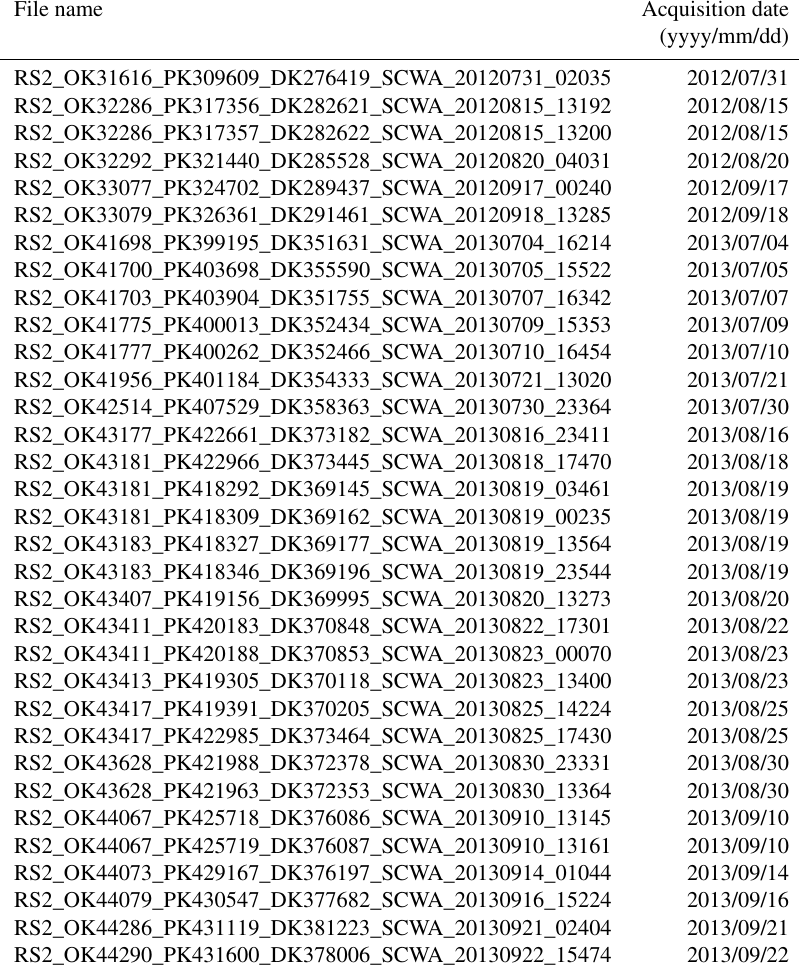
Table A3. Probability of a polygon being assigned correctly within ± 0 , 1 , 2 , 3 ice concentration categories (user’s accuracy, or p(m | x) ). ˆ p refers to the point estimate of the likelihood found in our sample data; lower and upper refer to the lower and upper 95% confidence intervals. Ice ± 0 ± 1 ± 2 ± 3 concentration ˆ p Lower Upper All